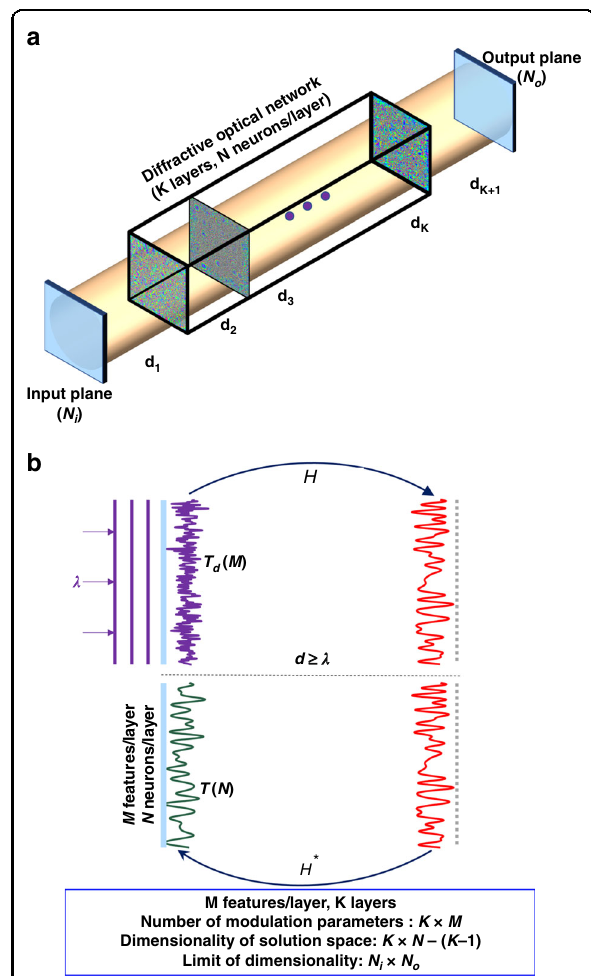
Fig. 1 Schematic of a multisurface diffractive network. a Schematic of a diffractive optical network that connects an input fi eld- of-view (aperture) composed of N i points to a desired region-of- interest at the output plane/aperture covering N o points, through K -diffractive surfaces with N neurons per surface, sampled at a period of λ /2 n , where λ and n represent the illumination wavelength and the refractive index of the medium between the surfaces, respectively. Without loss of generality, n = 1 was assumed in this paper. b The communication between two successive diffractive surfaces occurs through propagating waves when the axial separation ( d ) between these layers is larger than λ . Even if the diffractive surface has deeply subwavelength structures, as in the case of, e.g., metasurfaces, with a much smaller sampling period compared to λ /2 and many more degrees of freedom ( M ) compared to N , the information-processing capability of a diffractive surface within a network is limited to propagating modes since d ≥ λ ; this limits the effective number of neurons per layer to N , even for a surface with M >> N . H and H * refer to the forward- and backward-wave propagation,